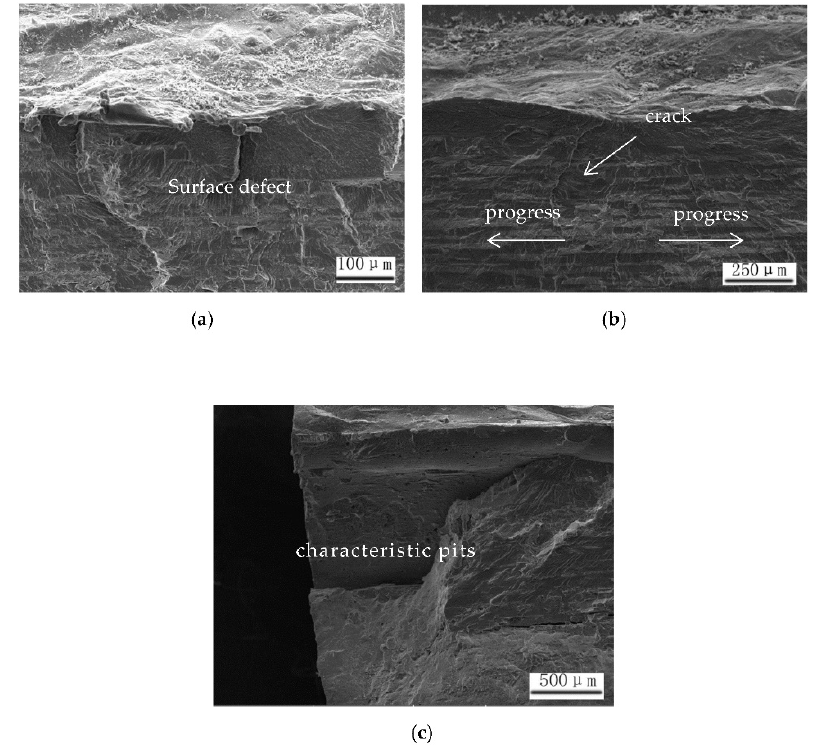
Figure 9. The SEM photographs of fracture of sample 3–5 fatigue cycle is 259,208. ( a ) crack initiation zone, ( b ) crack propagation zone, ( c ) final fracture zone.